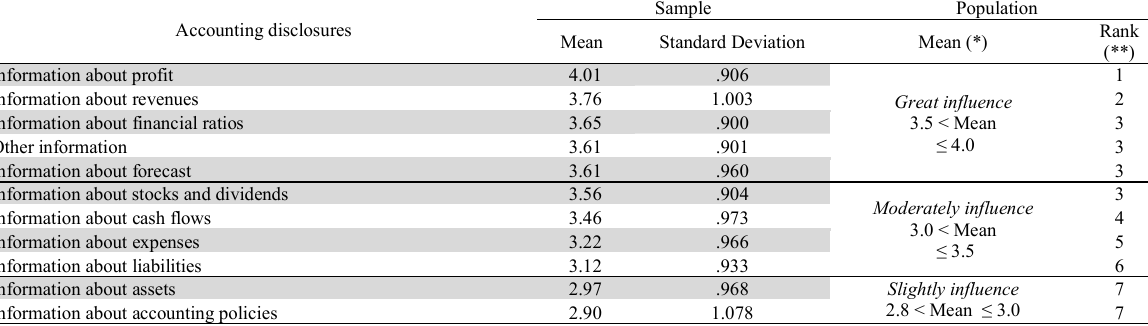
Level of influence of accounting disclosures